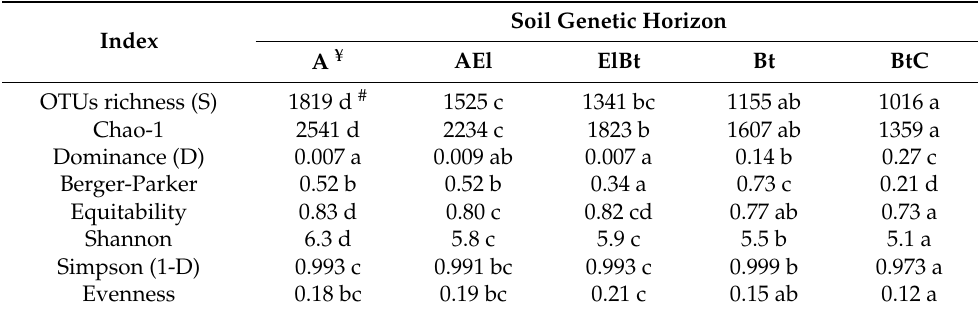
Table 3. Fungal OTU biodiversity indices of the Phaeozem genetic horizons under undisturbed birch forest (means).